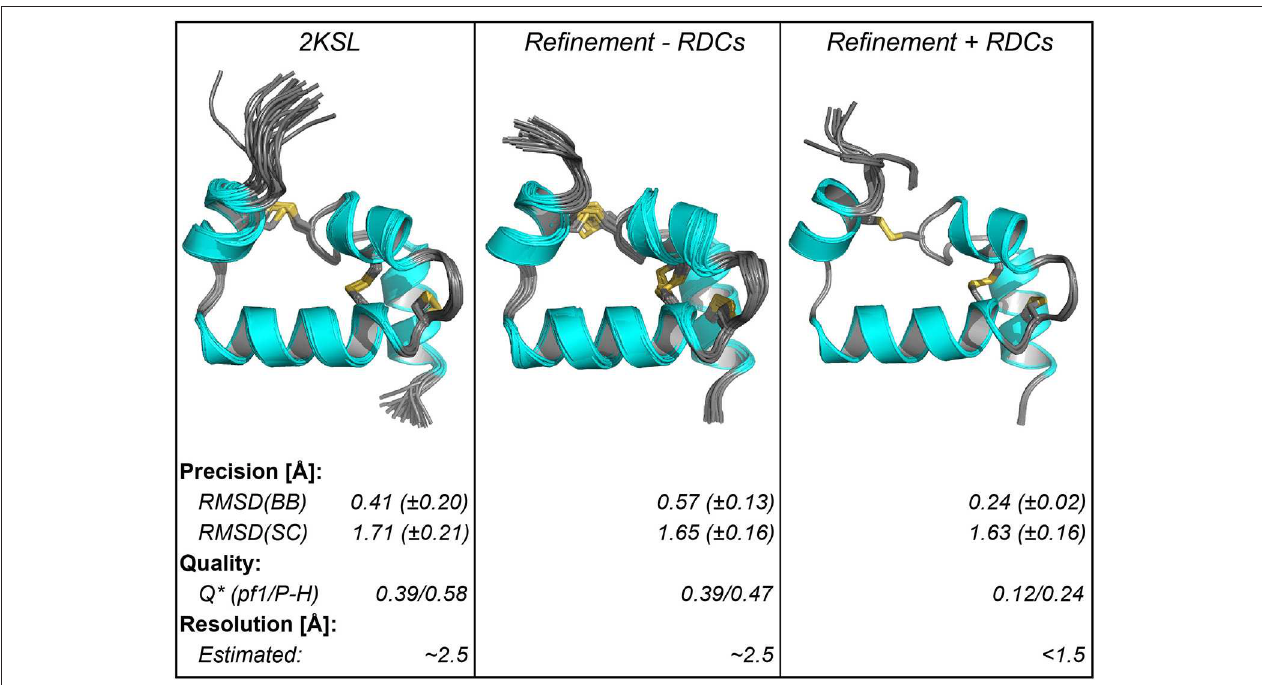
FIGURE 3 | Structural parameters of ensembles of Ta1a structures using different refinement methods. The left panel shows the published structure, the middle and right panels show the refinement of the structure based on additional data acquired here, either excluding the RDC data (middle) or including the RDC data (right). Below the structure the structural parameters are summarized. The quality factor (Q) was calculated using the RDC data in the two different alignment media (Pf1-phage [pf1] and PEG-hexanol liquid crystals [P-H]). The data show that improvement in Q factor when including RDCs is consistent with a crystallographic resolution where sidechains can be resolved. *The quality factor for the RDC refined structure was determined using a procedure where RDCs used in the refinement are excluded when deriving the Q factor (Q free